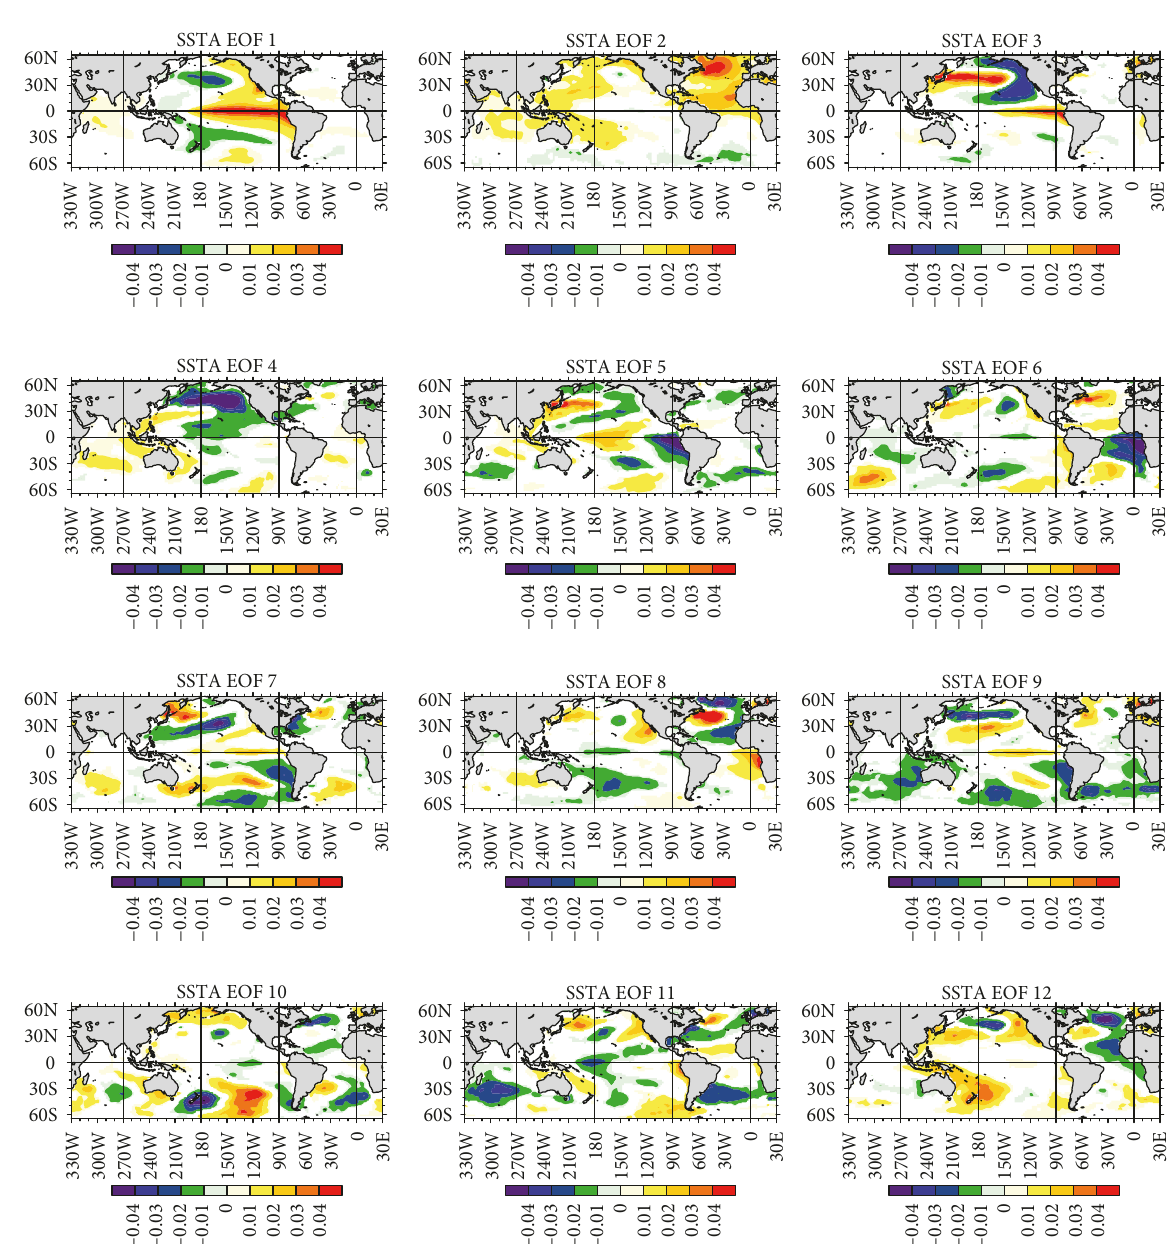
Figure 3: Maps of the 12 variance-leading, spatially normalized EOFs of the monthly SSTAs field, computed in the period 1910–2011. Ranked EOFs are read from left to right and top to